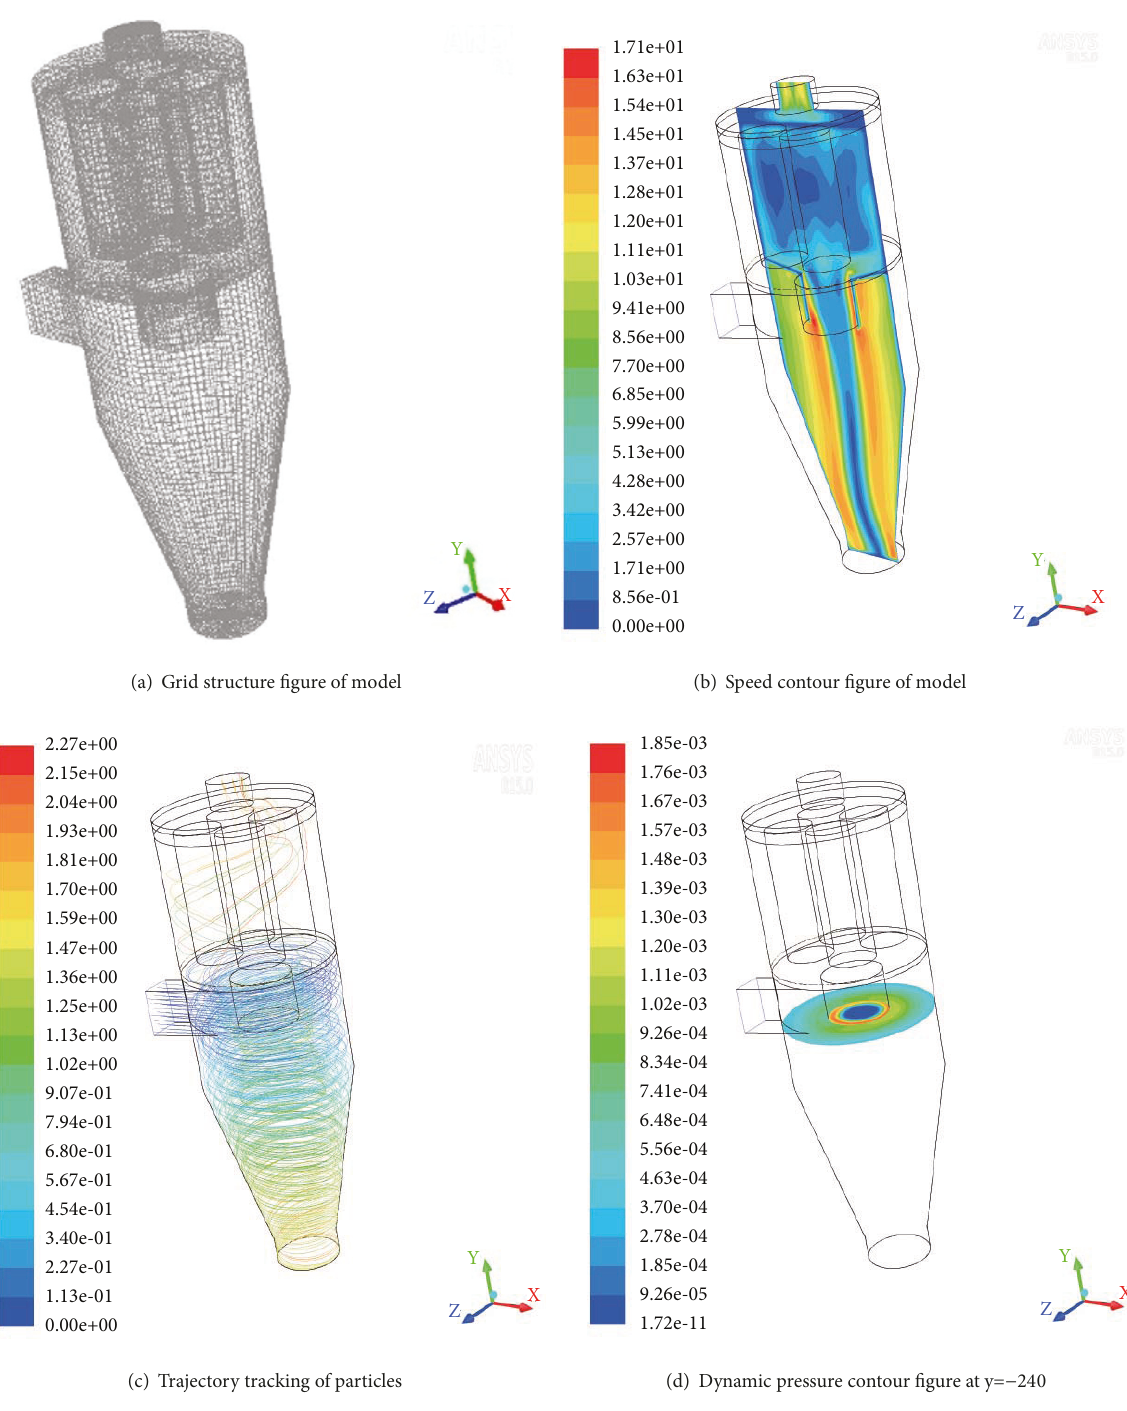
(c) Trajectory tracking of particles (d) Dynamic pressure contour figure at y= − 240 Figure 3: Grid and simulation contour figure of combined